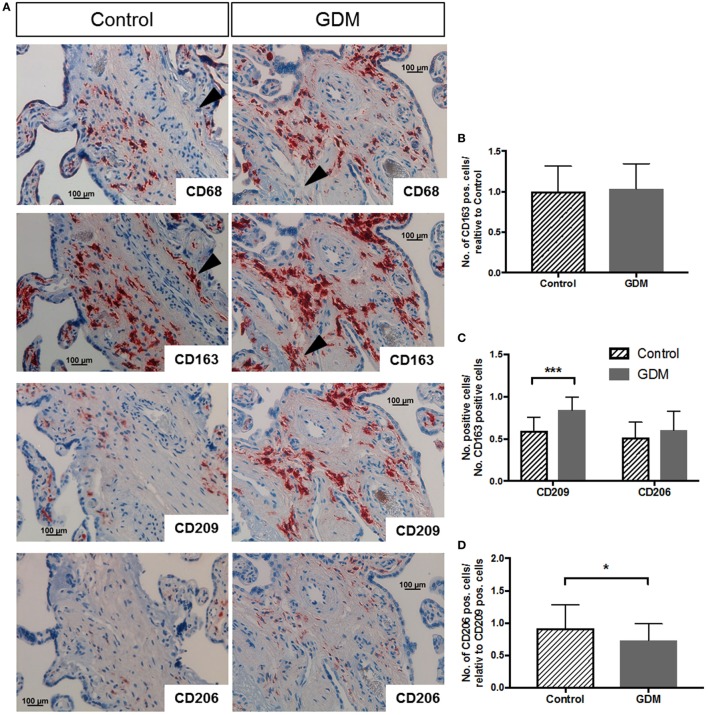
Immune histochemical assessment of M2 macrophage markers in placental tissue. (A) Immune histochemical staining against CD68 (top), CD163 (second from top), CD209 (next-to-bottom), and CD206 (bottom) in control (left hand side) and gestational diabetes mellitus (GDM) (right-hand side) placenta. Black arrowheads in CD68 and CD163 pictures indicate regions of (i) absence of CD68 but (ii) presence of CD163 staining in the same region, underpinning that CD68 is not the best marker for Hofbauer cell (HBC) detection. Images representative of serial sections from four different placentas per group are shown. (B) Quantification of CD163-positive HBC in control and GDM placenta. (C) Quantification of CD209 and CD206 positive cells in control and GDM placenta relative to the number of CD163 positive cells. An increase in CD209 positive cells in GDM tissue was observed. (D) Number of CD206 positive cells relative to CD209 positive cells. A decrease in the number of CD206 positive cells in GDM was observed. All data in (B–D) are presented as mean ± SD; t-test (B,D) and one-way ANOVA (C).